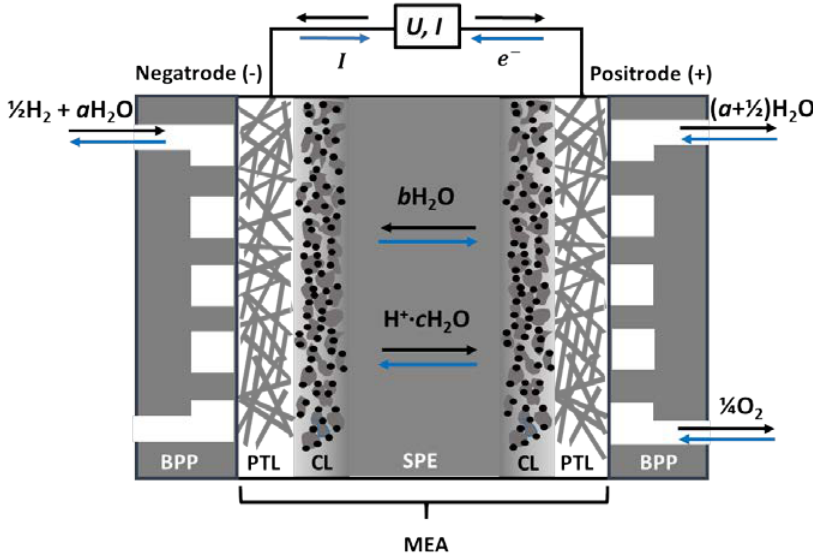
Figure 2. Schematic of PEM electrochemical cells (PEMECs)—fuel cells (PEMFC, black upper arrows) and electrolysers (PEMEs, blue lower arrows). Protons hydrated with c bonded and electro-osmotically dragged H 2 O molecules migrate through the solid polymer electrolyte (SPE), the water supplied by b back-diffusing water, and a water supplied in a feed gas, so that a + b = c . BPP: bipolar plate gas manifold, PTL: Porous transport layer, CL: catalyst layer, SPE: solid polymer electrolyte, MEA: membrane electrode assembly.